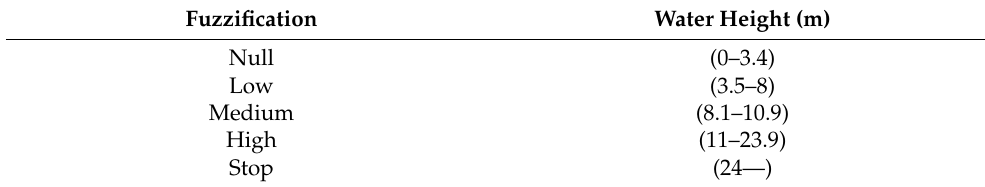
Table 3. Fuzzification of water height.